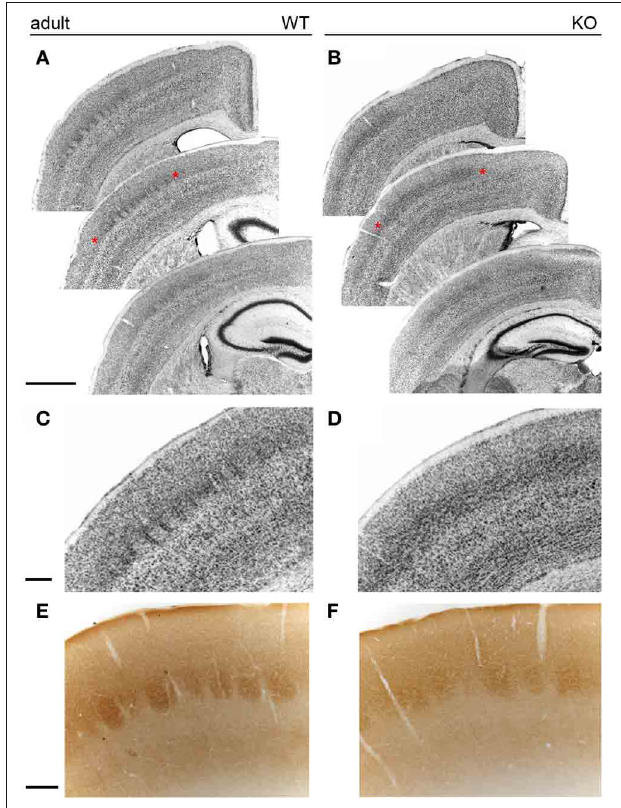
FIGURE 8 | The barrelfield in the adult somatosensory cortex. In wild type animals (A) , Nissl staining revealed individual cytoarchitectonic units (barrels) in layer IV of the somatosensory cortex. In contrast, Nissl staining of NCAM mutant mice (B) showed less distinct barrels. (C,D) Enlarged views of the areas marked with asterisks in (A,B) . While septa were evident in wild type animals (C) , null mutant mice (D) lacked well-delineated septa and layer IV cells formed horizontally placed microlaminae in knockout mice. (E,F) Cytochrome oxidase histochemistry of coronal sections revealed no obvious changes between wild type and null mutant mice. Bars: A , B , 1mm (in A ); C , D , 200 μ m (in C ); E , F , 200 μ m (in E